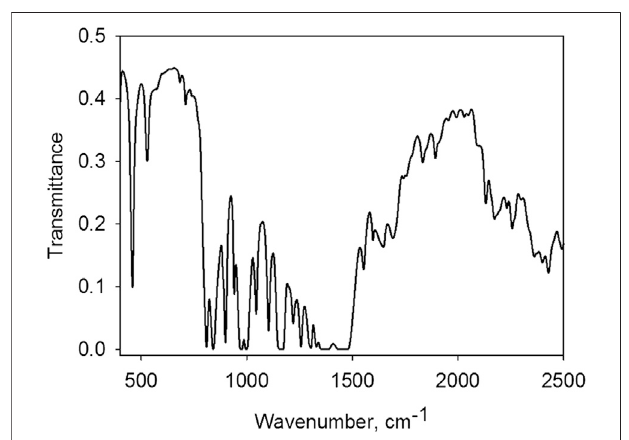
FIGURE 5 | Tube wall transmission